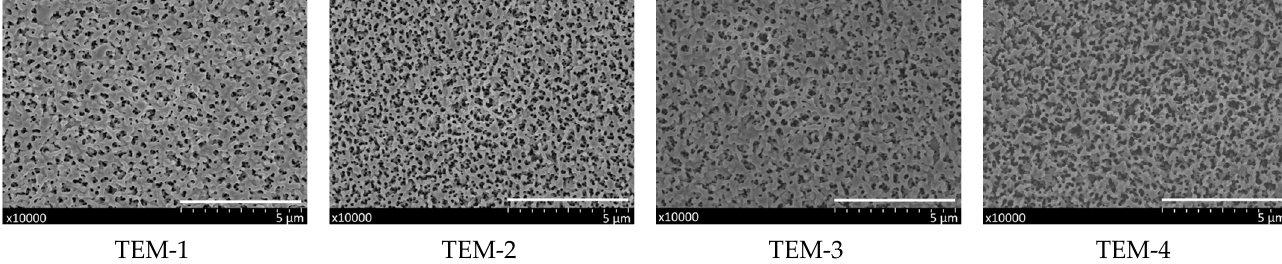
Figure 4. SEM images of side b of membranes TEM-1, TEM-2, TEM-3 and TEM-4 (from the left to the right). Scale bar, 5 μ m.